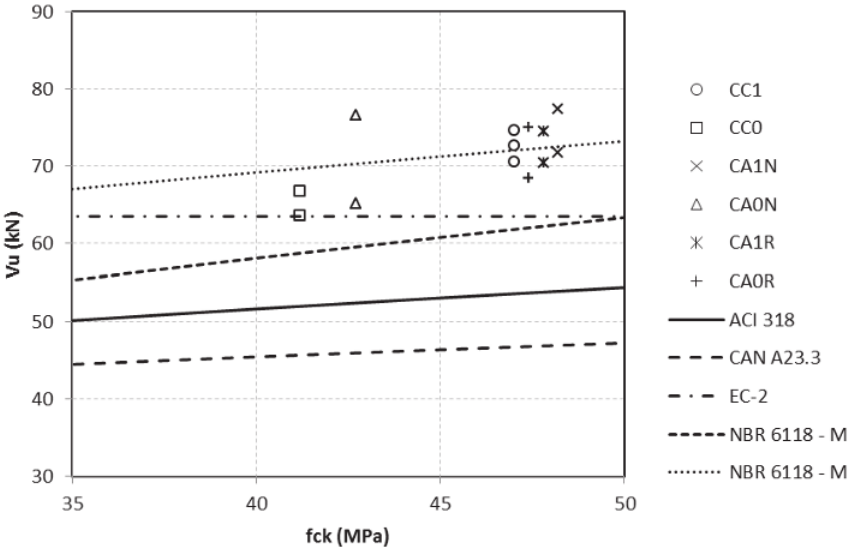
Figure 7 Code based prediction and experimentally measured of ultimate shear force vs. concrete compressive